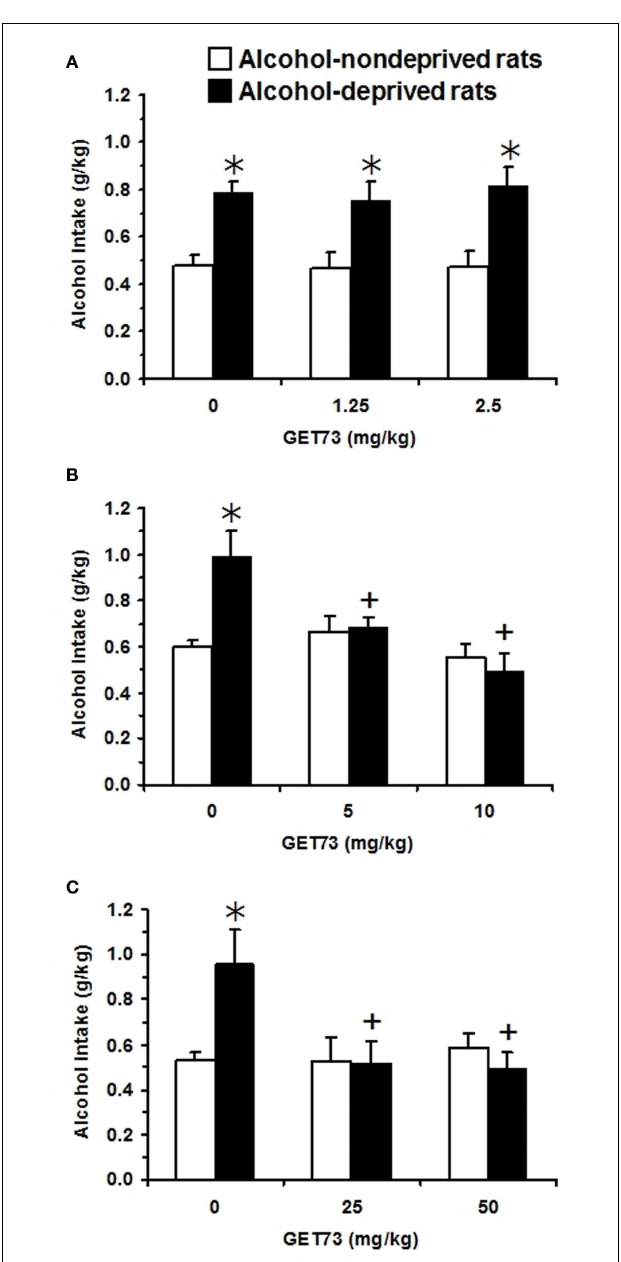
FIGURE 8 | Effect of theacute, intragastric administration of low (A), moderate (B), and high doses (C) of GET73 – tested in three independent experiments – on the “alcohol deprivation effect” (ADE) in Sardinian alcohol-preferring (sP) rats. Alcohol (10% v/v, in water) was offered under the standard, homecage two-bottle “alcohol vs water” choice regimen with unlimited access for 24h/day. Alcohol-deprived rats were deprived of alcohol for 14 consecutive days; alcohol-non-deprived rats had continuous access to alcohol and water.Thirty minutes before representation of the alcohol bottle (which coincided with lights off), both alcohol-deprived and -non-deprived rats were treated acutely with GET73. Alcohol intake was registered 60min after lights off. Each bar is the mean ± SEM of n = 7–18. * P < 0.05 with respect to alcohol-non-deprived rats receiving 0mg/kg GET73 (Newman–Keuls test); + P < 0.05 with respect to alcohol-deprived rats receiving 0mg/kg GET73 (Newman–Keuls